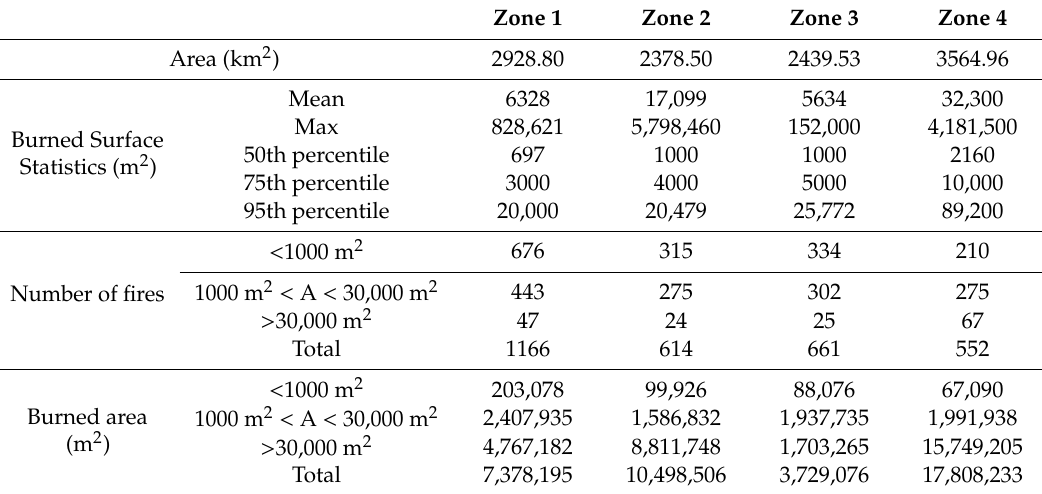
Table 1. Summary of burned area and number of wildfires according the subdivision of zones in the study area